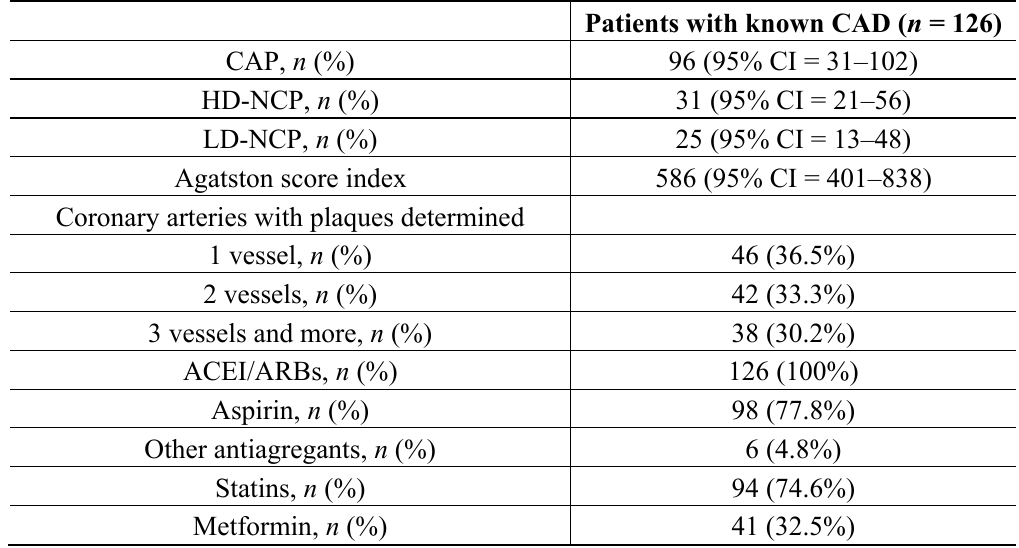
Table 2. Baseline Angiographic and Treatment Characteristics of patients with known